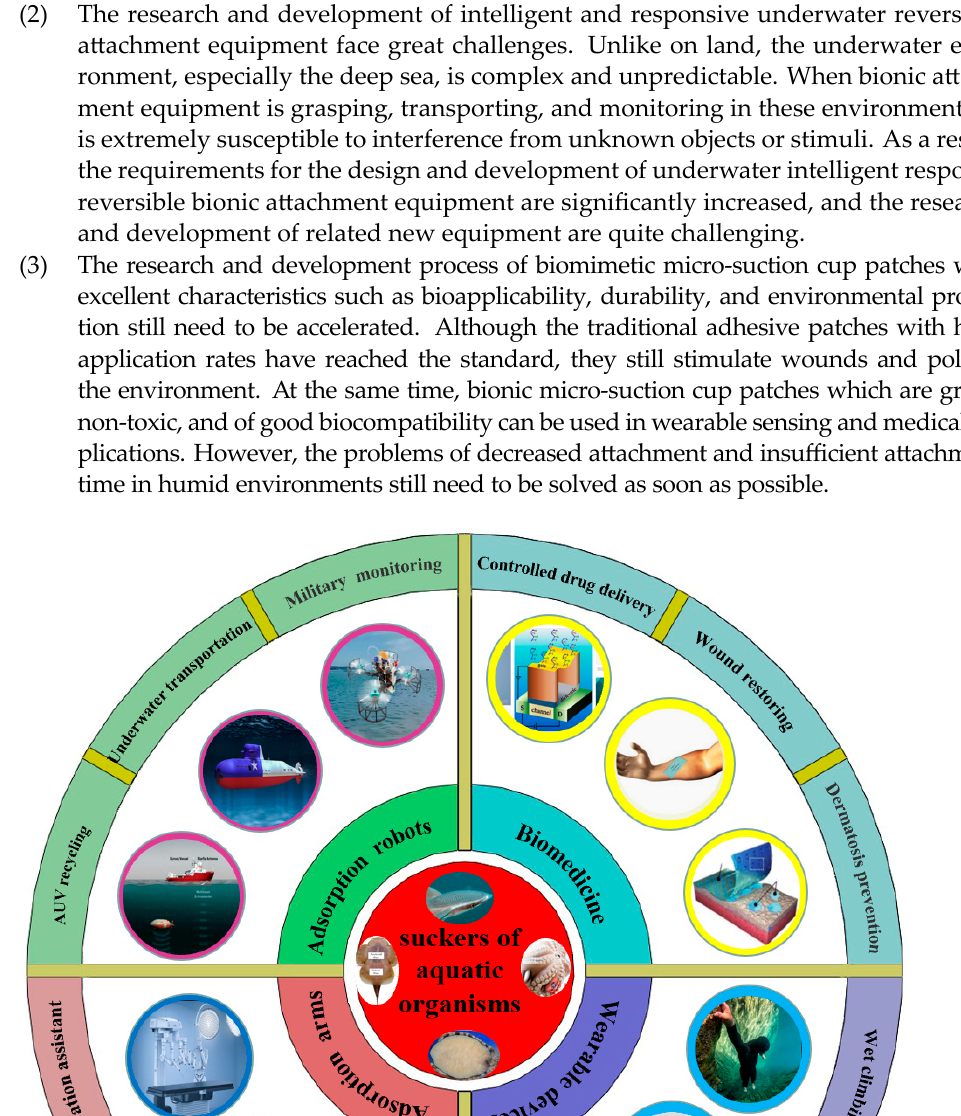
future. For example, the attachment robot inspired by the remora can record video on